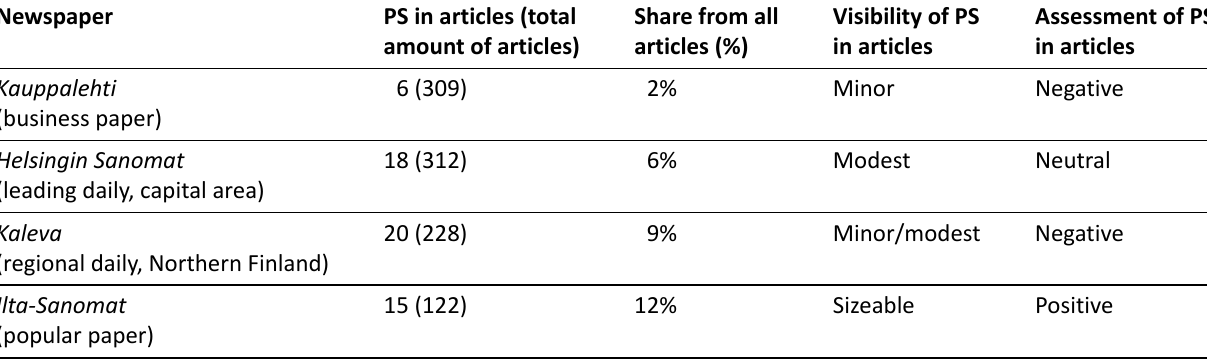
Table 1. Finns Party (PS) in Euro crisis articles (n =